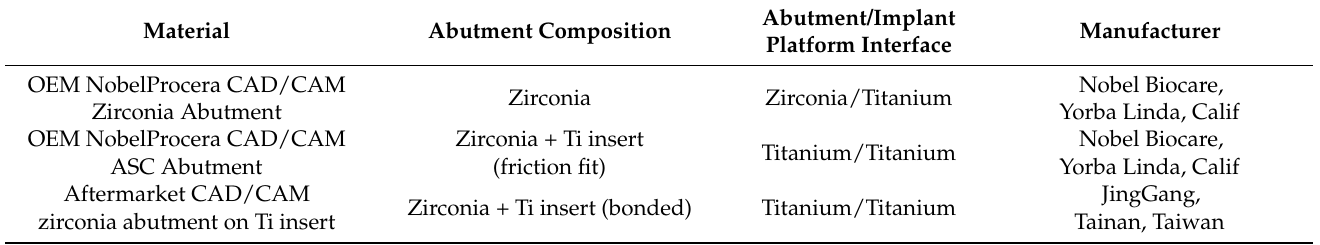
Table 1. Zirconia abutments evaluated.